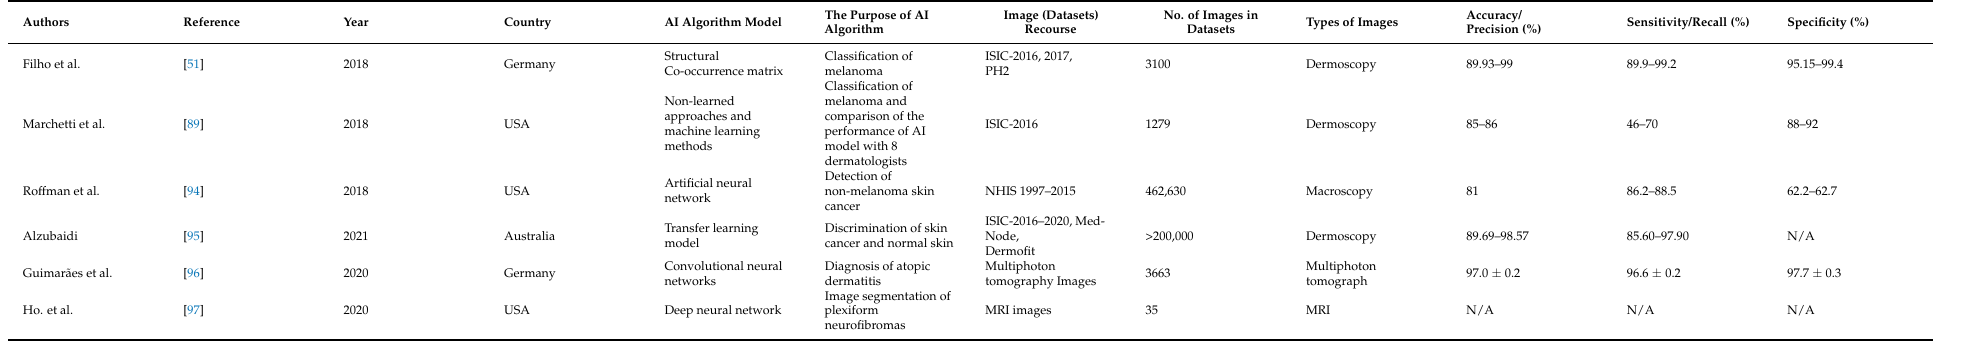
Table 3. The application of AI in binary classification for skin